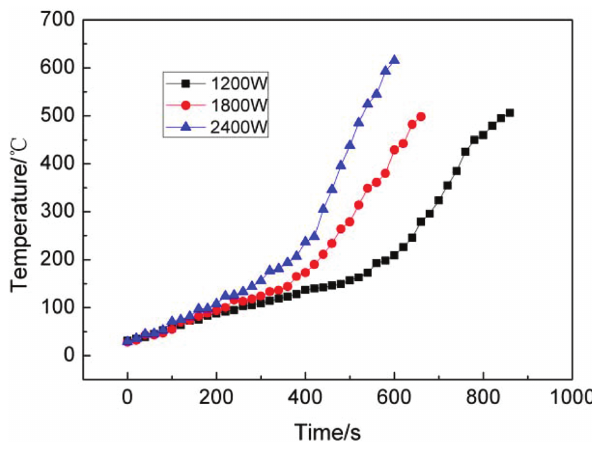
Figure 9: Heating-rate curves of the CuCl residue at different micro- wave power levels.